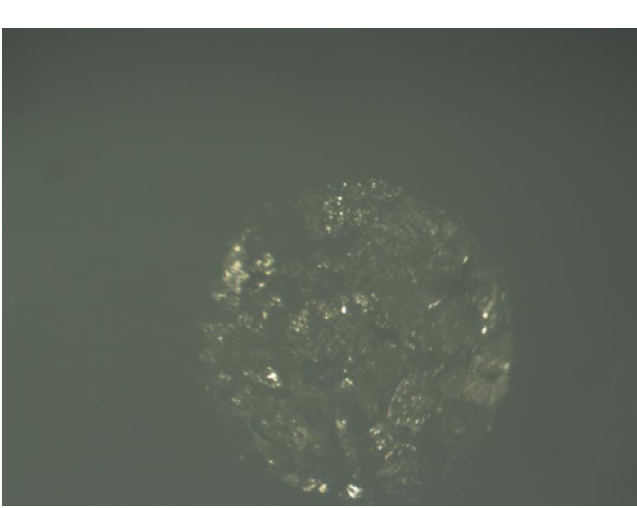
Figure 6. Inverted metallurgic microscope images of PME.